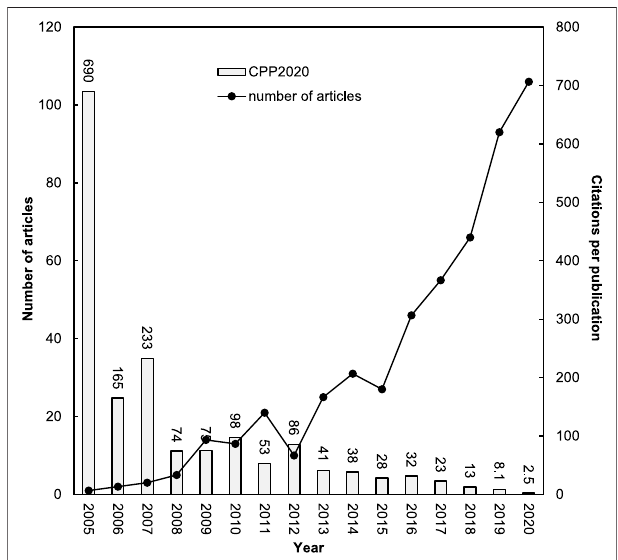
FIGURE2| Numberofbacterialnanocellulosearticlesandtheircitations per publication by year.